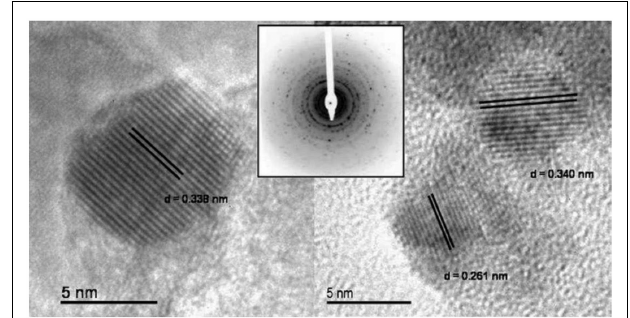
FIGURE 6 | High resolution-transmission electron microscopy (HR-TEM) micrographs and selected area electron diffraction (SAED) patterns (insert) of Eu 3 + -doped ZnS (EZS) sample after firing at 500 o C (Planelles-Arago et al., 2008) .